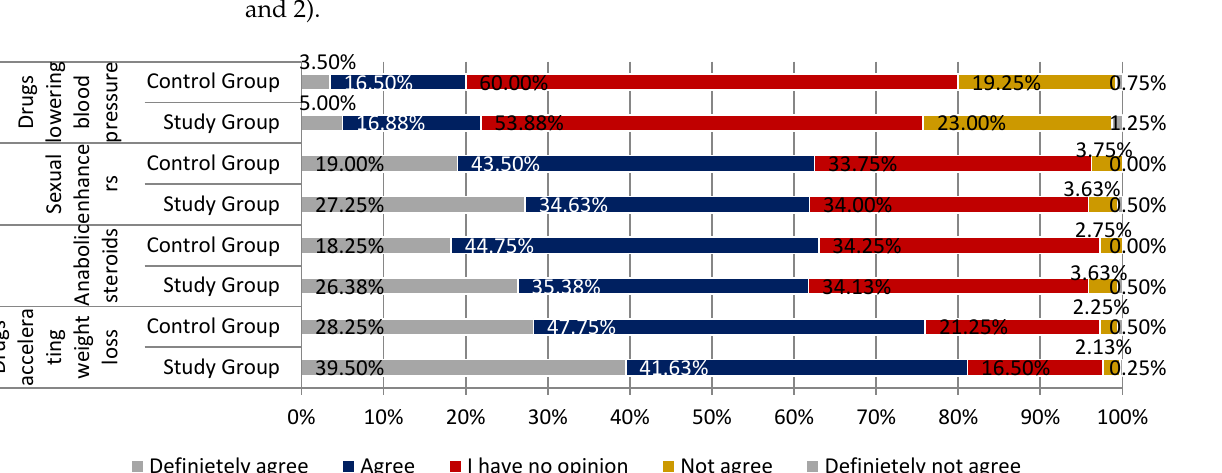
Figure 7. Falsified drugs in the opinion of respondents from the study and control group part 3. Respondents from both groups agreed with the statement that the most commonly falsified drugs are those accelerating weight loss. A larger percentage of people convinced this statement is true was observed in the study group (respectively, 81.13% of respondents in the study group and 76.00% in the control group; p < 0.01). Compared to the previous statement, a slightly smaller number of respondents considered anabolic steroids as the most common drugs that are falsified (respectively, 61.76% and 63.00% of responses; p < 0.01). In the case of drug potency, the distribution of responses was similar to that achieved in the context of anabolic steroids. Sexual enhancers were believed to be the most commonly falsified drugs. A small group of respondents agreed with the statement that antiplatelet and antithrombotic drugs are the most commonly falsified drugs (18.63% of respondents from the study group and 16.25% of the respondents from the control group). Every fourth respondent did not consider this sentence correct (23.63% and 23.75% of respondents). This part of the questionnaire is summarized in Figures 8 and 9 (parts 1 and 2).